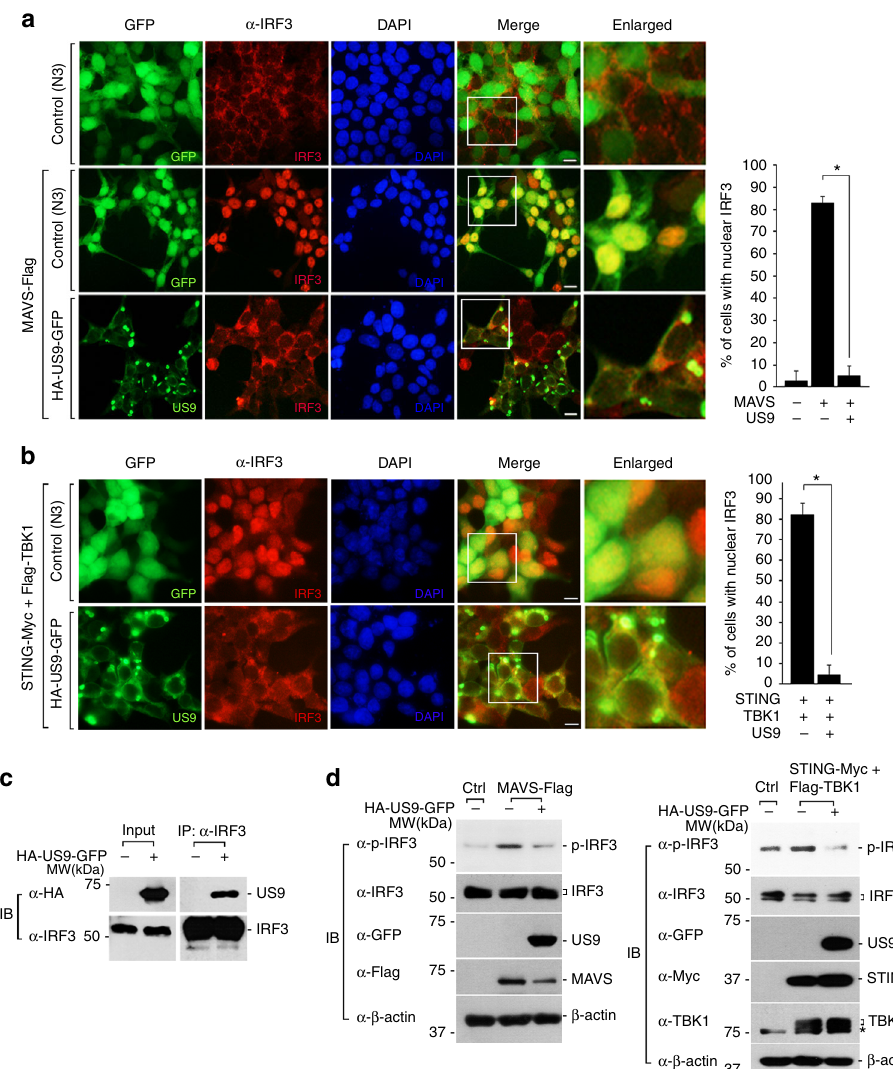
Fig. 4 US9 impedes MAVS- and STING-mediated IRF3 nuclear translocation. a US9 blocks MAVS-induced IRF3 nuclear translocation. HEK293T cells were transfected with the indicated plasmids and immunostained with anti-IRF3 antibody, followed by AlexaFluor 568-conjugated antibody. The nuclei were stained with DAPI. Right graph, percentage of cells with nuclear IRF3. Scale bars, 10 μ m. * P < 0.005 (Student ’ s t test). b US9 blocks STING – TBK1-induced IRF3 nuclear translocation. HEK293T cells expressing STING-Myc and Flag-TBK1 were transfected with HA-US9-GFP. IFA was performed by immunostaining with anti-IRF3 antibody. The nuclei were stained with DAPI. Right graph, percentage of cells with nuclear IRF3. Scale bars, 10 μ m. * P < 0.005 (Student ’ s t test). c US9 interacts with IRF3. Cell lysates of HEK293T cells expressing mock or HA-US9-GFP were subjected to immunoprecipitation with anti-IRF3 antibody. Immunoprecipitates were resolved by SDS-PAGE and then subjected to immunoblotting with anti-HA and anti-IRF3 antibodies. d US9 inhibits MAVS- and STING/TBK1-induced IRF3 phosphorylation. HeLa cells were transfected with the indicated plasmids and total lysates were analyzed by immunoblotting with the indicated antibodies. Asterisk indicates endogenous TBK1. Data are representative of three independent experiments and are presented as mean ± s.d. in a and